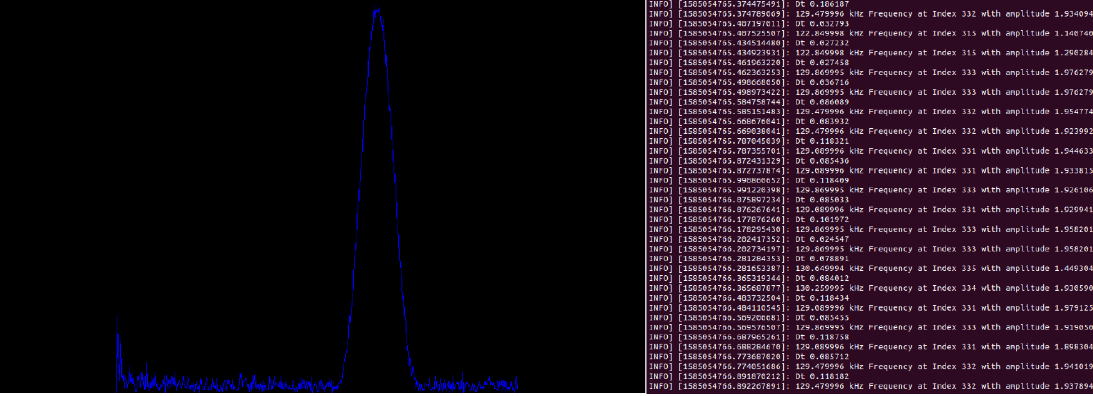
Figure 14. Unscaled FFT output displayed on an image stream in real-time using OpenCV and the dominant frequency in each computation printed to a